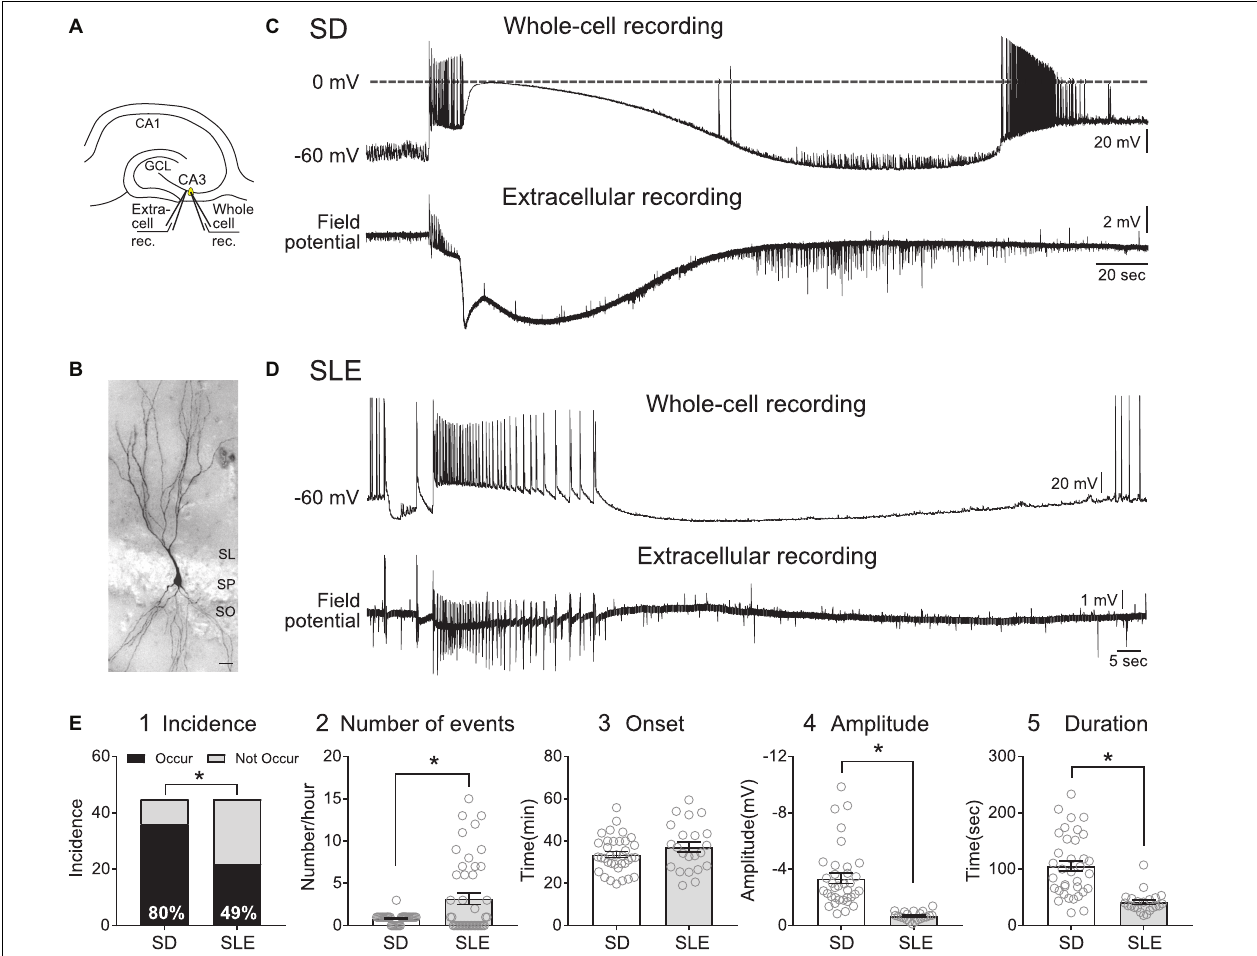
FIGURE 2 | SD and SLEs are two main types of events with distinct characters in the 0 Mg 2 + /5 K + aCSF slice model. (A) Schematic illustrates the recording sites for simultaneous field potential and whole-cell recordings in CA3. (B) A representative image of a recorded and biocytin-filled CA3 pyramidal cell. SL, stratum lucidum; SP, stratum pyramidale; SO, stratum oriens. Scale bar, 20 µ m. (C) Example of an SD. The intracellular and extracellular characteristics of SD are shown. (D) Example of a SLE. The intracellular recording shows characteristics such as a sudden depolarization and extensive firing. (E) Comparisons between SD and SLEs. (E1) In a 60-min recording period. SD showed a higher incidence than SLEs (two-sided Fisher’s exact test, p = 0.02; asterisk indicates p < 0.05. (E2) In a 60-min recording period, more SLEs occurred than SDs (Wilcoxon test, p = 0.01). (E3) The onset of the first SD and SLE was not significantly different